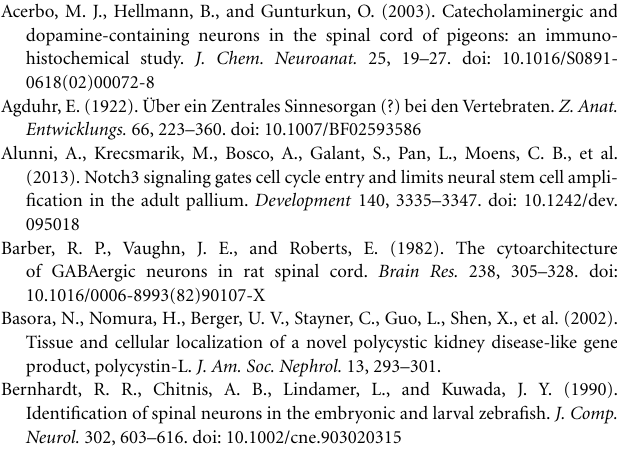
Number of cells